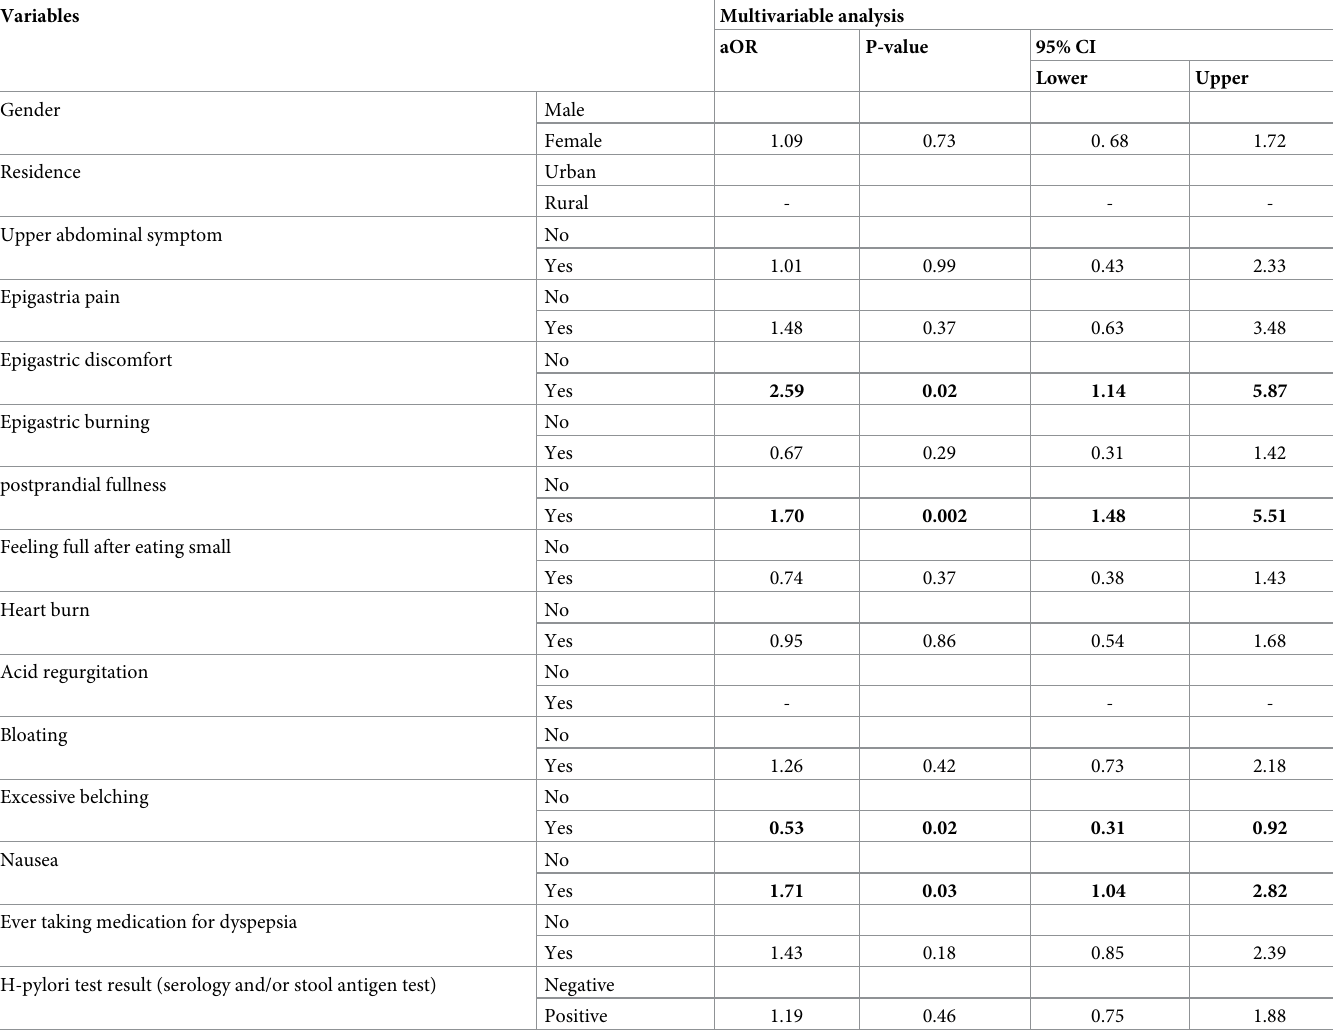
Table 2. Factors associated with probable case of depression among patients with dyspepsia in